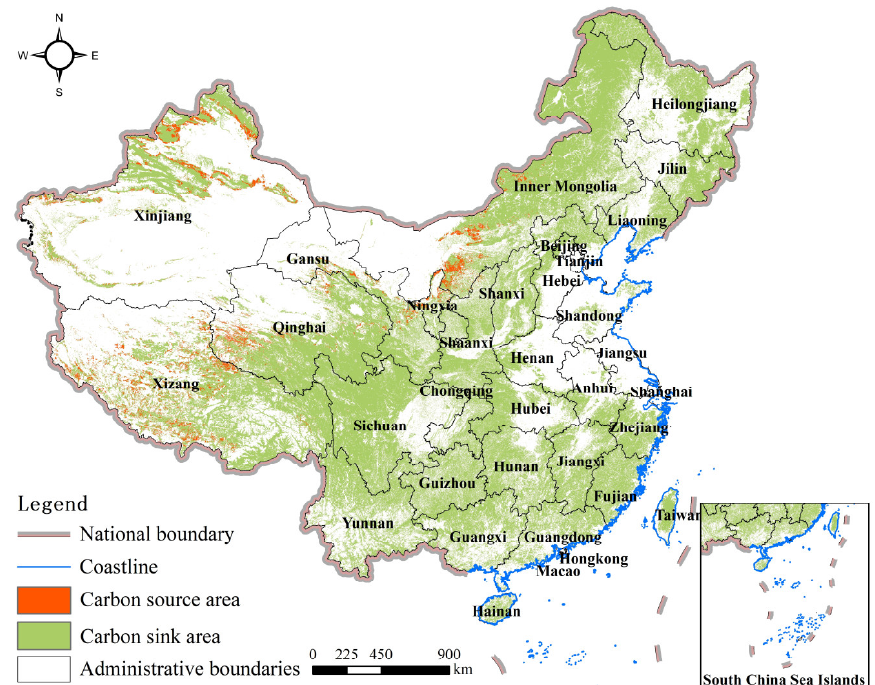
Figure 5. Spatial distribution of cumulative NEP of CES.